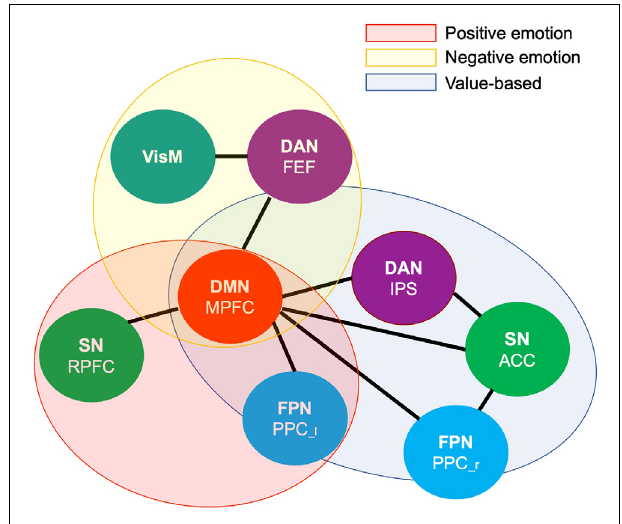
FIGURE 5 | Venn diagram illustrating shared and distinct networks among value-based and emotional valence prioritization effects. DMN.MPFC (medial prefrontal node of the default mode network), FPN.PPC [left (l) and right (r) posterior cingulate cortex of the Frontoparietal network], DAN.FEF (bilateral frontal eye field of the Dorsal Attention network), DAN.IPS (intraparietal sulcus of the Dorsal Attention network), SN.RPFC (rostral prefrontal cortex of the Salience network), SN.ACC (anterior cingulate cortex of the salience network), VisM (visual medial